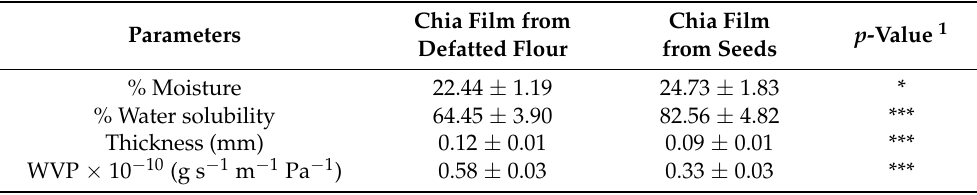
Table 1. Properties of the chia films made with different matrixes (mean ±